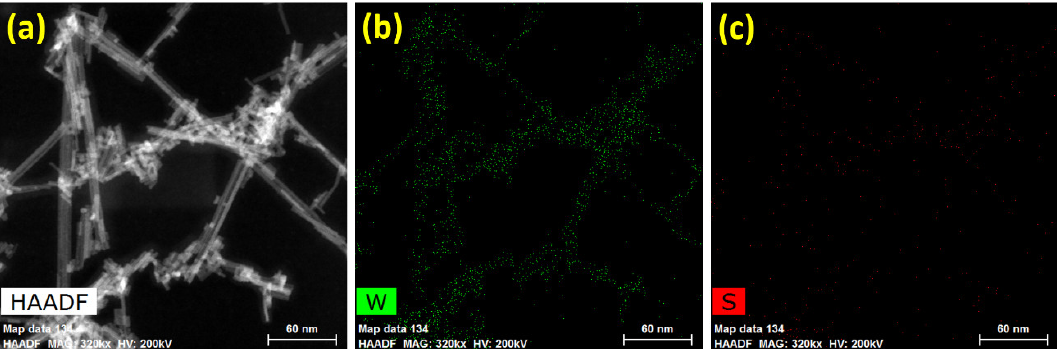
Figure 4. ( a ) HAADF image and corresponding color mapping of ( b ) tungsten and ( c ) sulfur elements of the WS 2 nanorods.